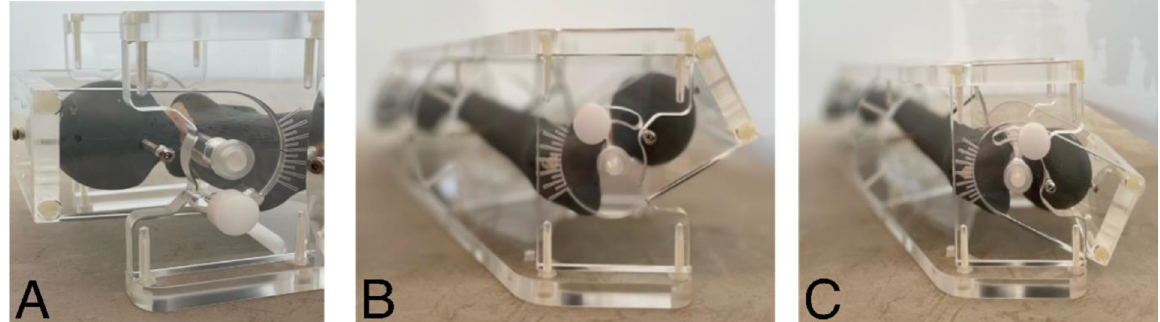
Fig 4. Overview of the sawbone 1 fixed in the goniometer and the measurement presets. A view of scale with 10˚ increments. B malrotation set to 30˚ anteversion. C malrotation set to 30˚ retroversion.